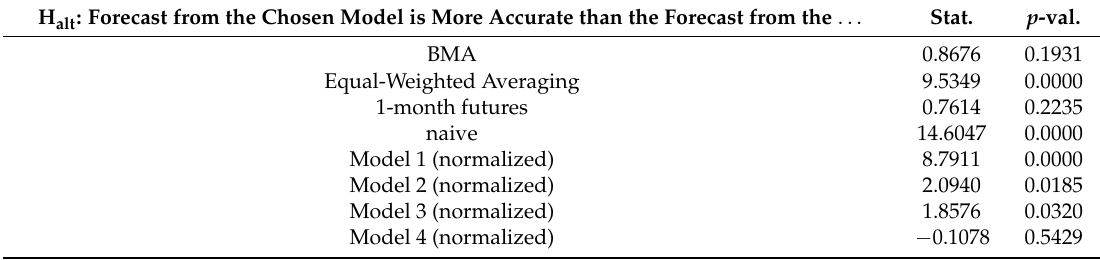
Table 5. Results of the Diebold-Mariano test for forecast accuracy. H alt : Forecast from the Chosen Model is More Accurate than the Forecast from the . . . Stat.